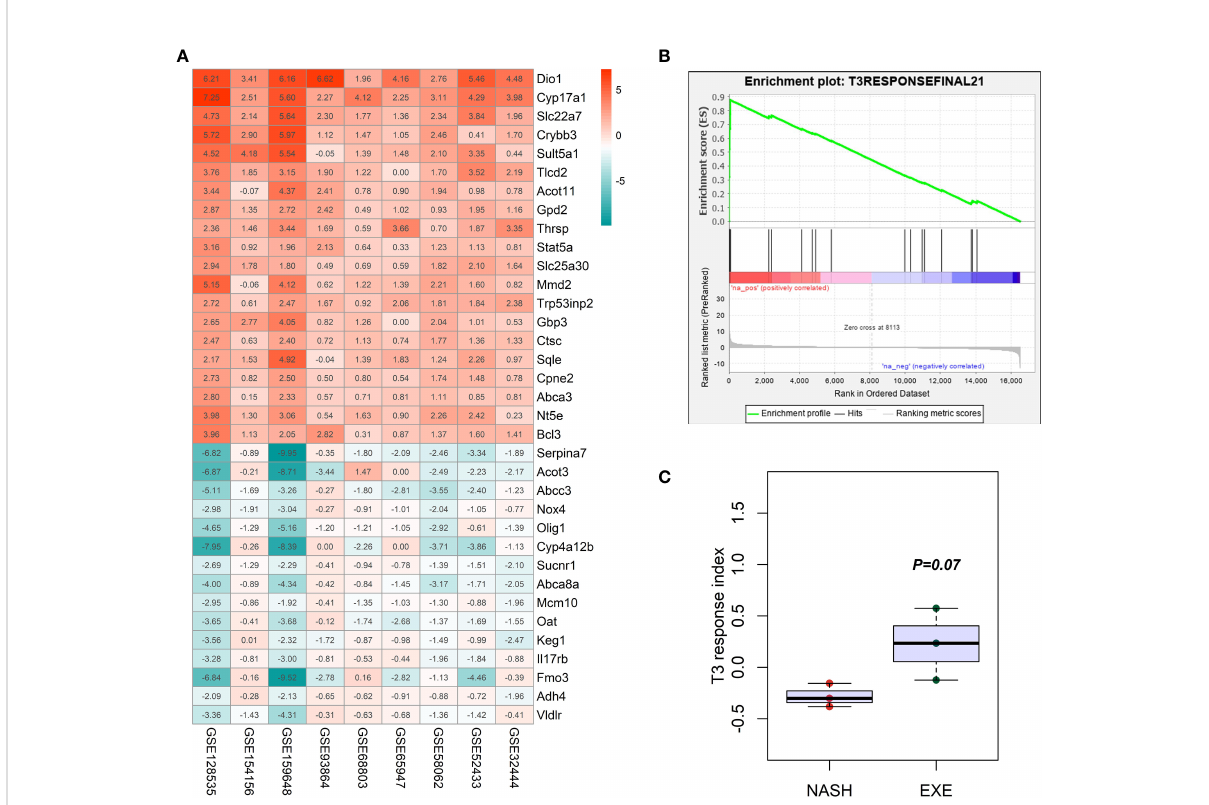
FIGURE 5 Construction and veri fi cation of T3 response signature. (A) Heatmap in the RRA analyses of 9 mice liver transcriptome datasets comparing T3 treated mice with non-treated mice. The number was for the log2 value offold change. Red color indicated the up-regulation of gene expression in the T3 treated mice liver tissues, while green color indicated the down-regulation of gene expression in the T3 treated mice liver tissues. (B) GSEA enrichment plot showing the signi fi cantly increased enrichment of T3 response signature in the NASH mice liver with aerobic exercise. (C) Comparison of the difference in the GSVA enrichment score of T3 response signature between NASH group and NASH+exercise